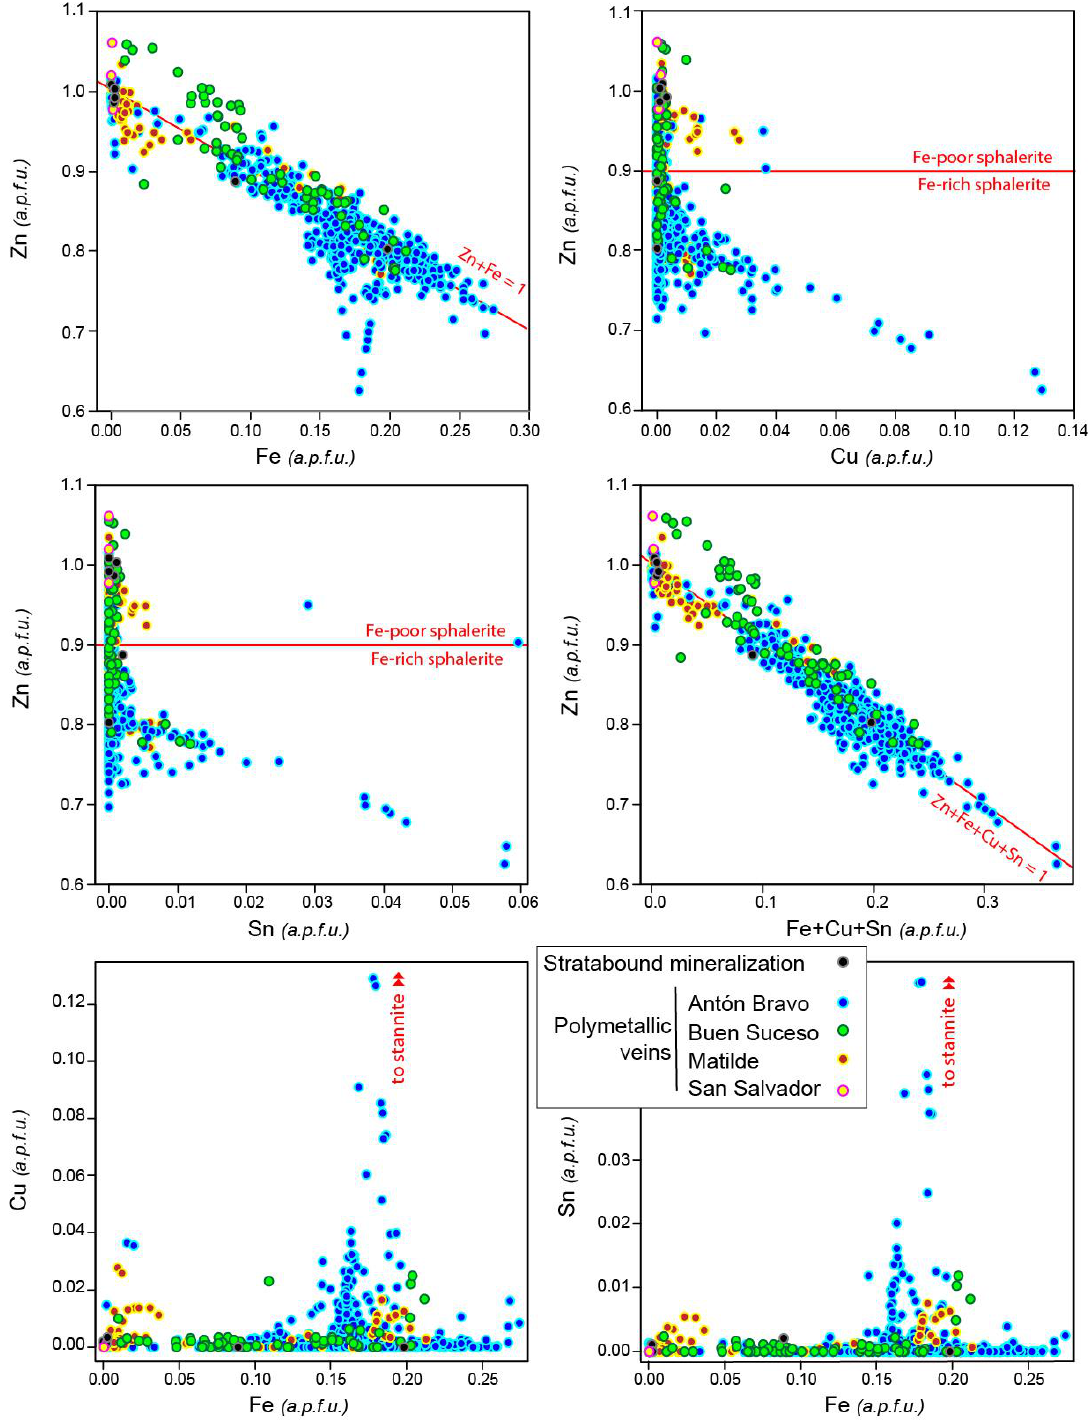
Figure 9. Correlation between elements in sphalerite from the Huari Huari district. The highest In concentrations occurred in Fe-rich sphalerite in the interval between 0.10 and 0.20 Fe p.f.u., but no clear correlation between these two elements was observed (Figure 10) despite the